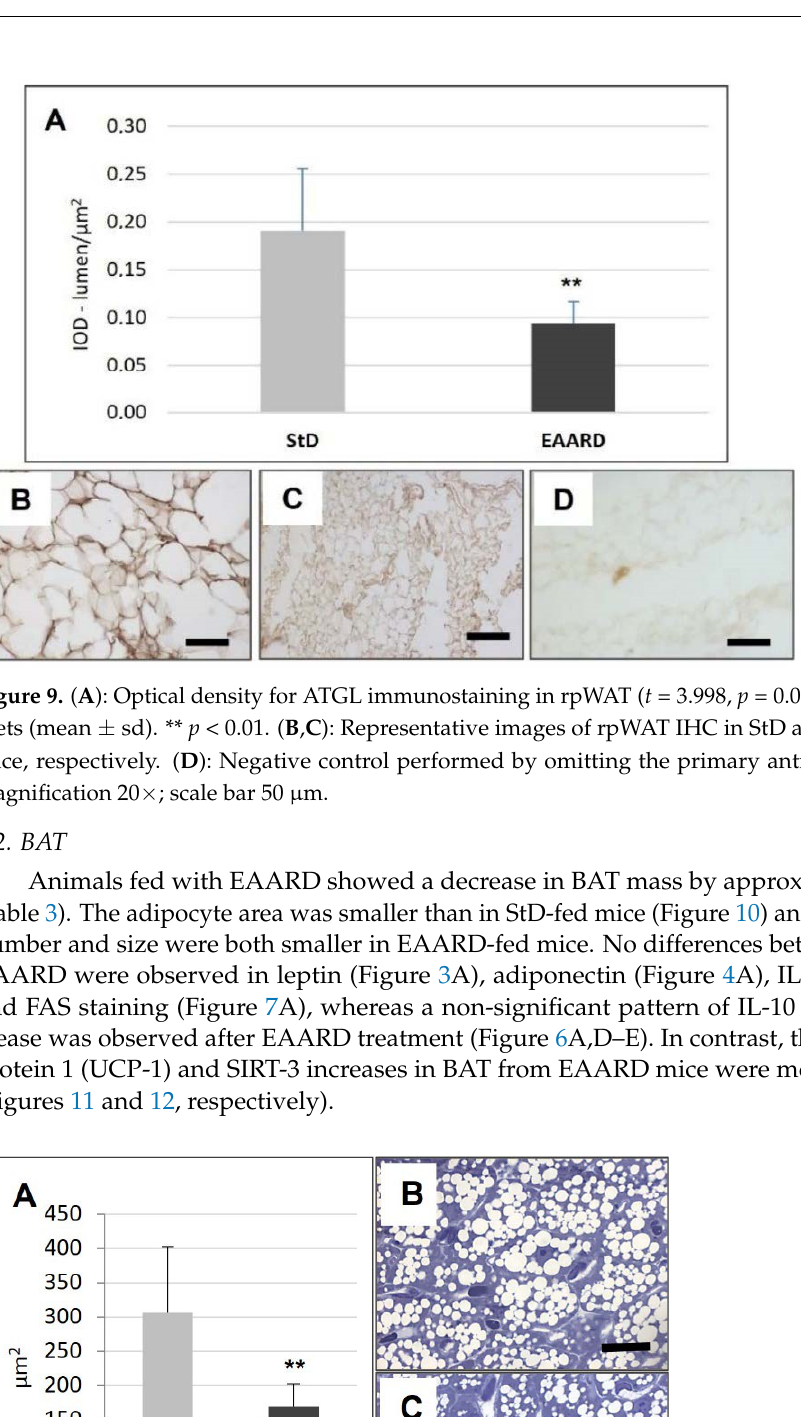
Figure 8. ( A ): Optical density for FADD immunostaining in rpWAT ( t = 1.402, p = 0.322) according to diet (mean ± sd). ( B , C ): Representative images of rpWAT IHC in StD and EAARD-fed mice, re- spectively. ( D ): Negative control performed by omitting the primary antibody. Original magnifica- tion 20×; scale bar 50 μm.